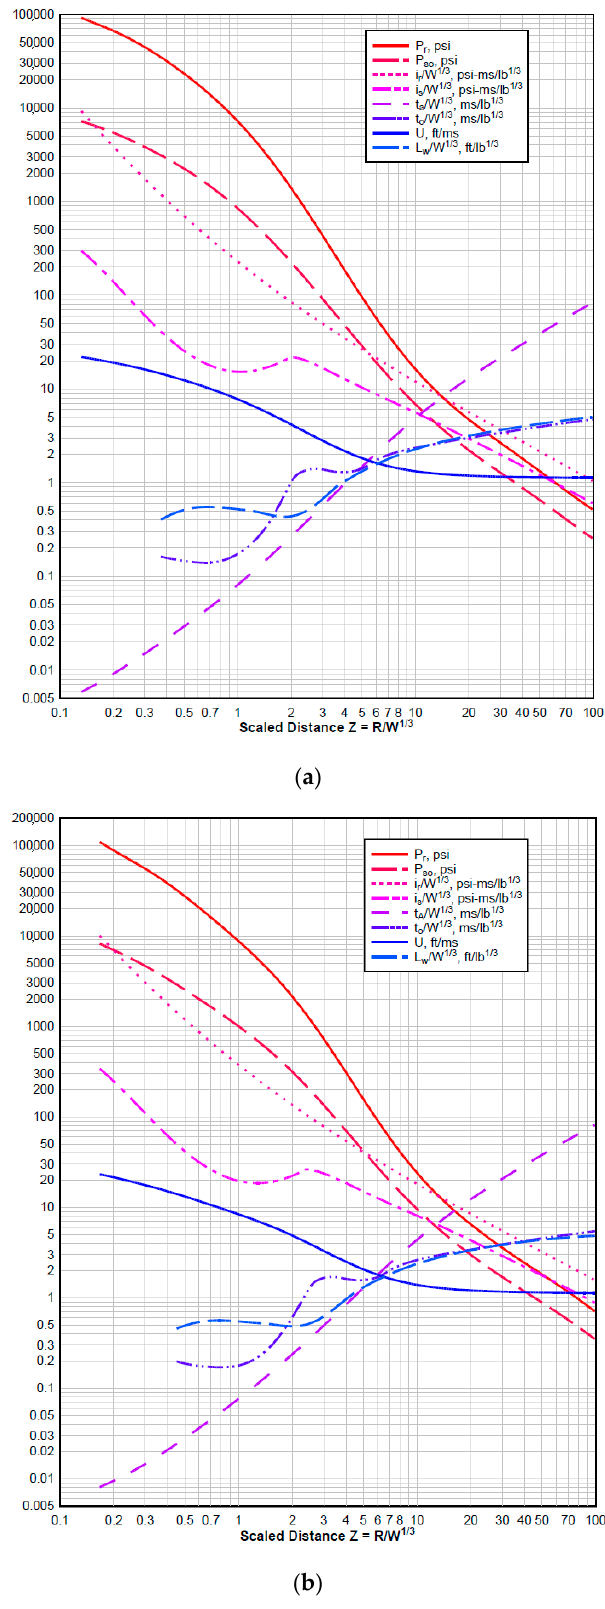
Figure 3. Positive phase shock wave parameters [15]: ( a ) Free-air burst; ( b ) Surface burst.